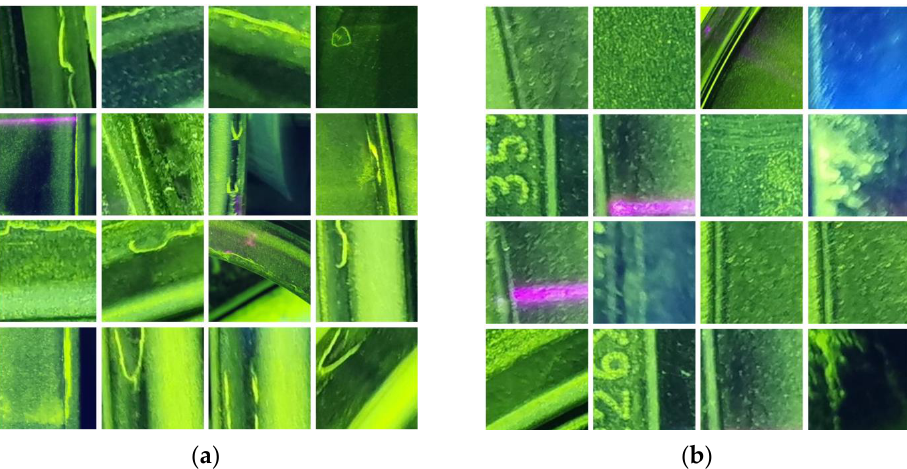
Figure 8. Bearing ring images of defective and non-defective patches from the dataset. ( a ) Defective patches; ( b ) Non-defective patches. Table 2. The dataset division for binary